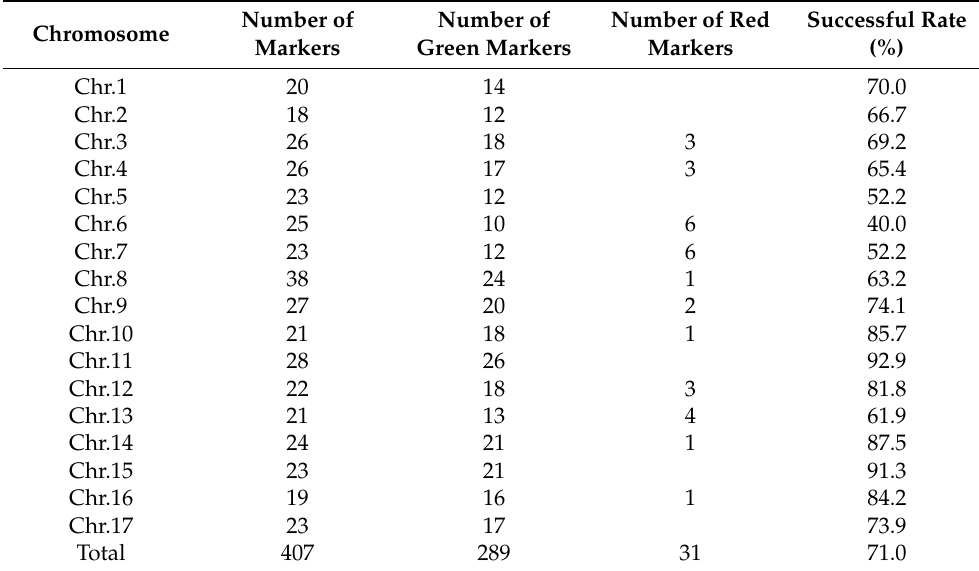
Table 2. Number of InDel markers that were polymorphic in pairwise comparison of five G. panic- ulata accessions.